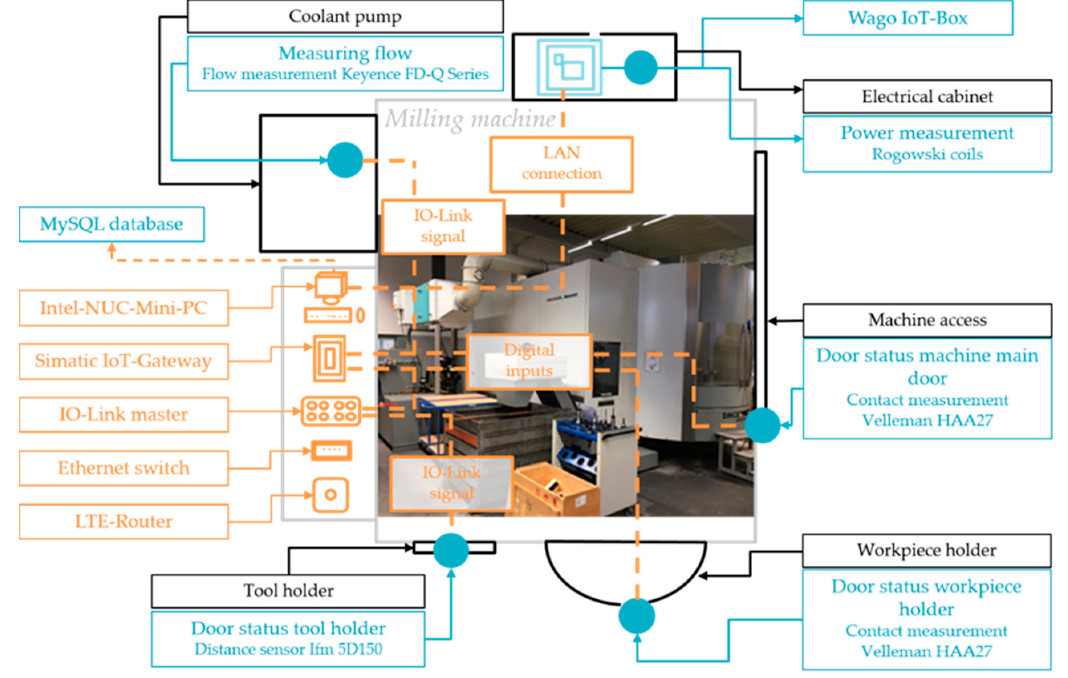
Figure 2. Milling machine and sensor setup.